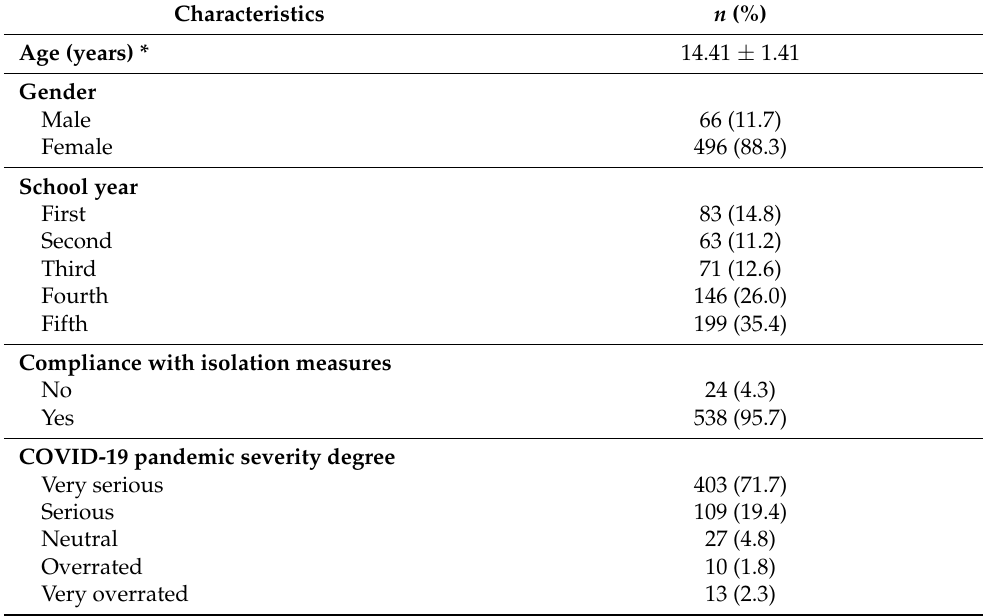
Table 1. Characteristics of participants ( n = 562).